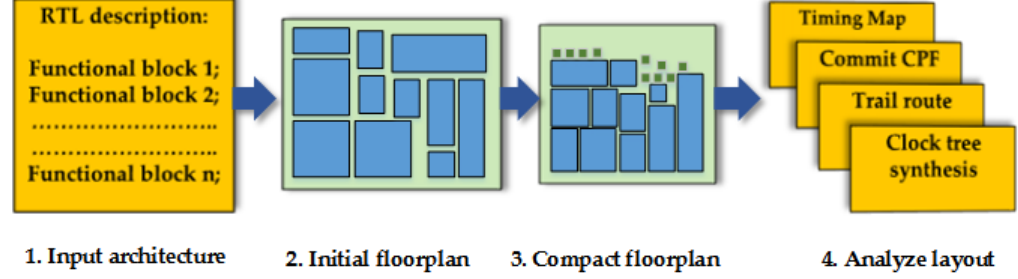
Figure 2. Design flow incorporated in Cadence tool for